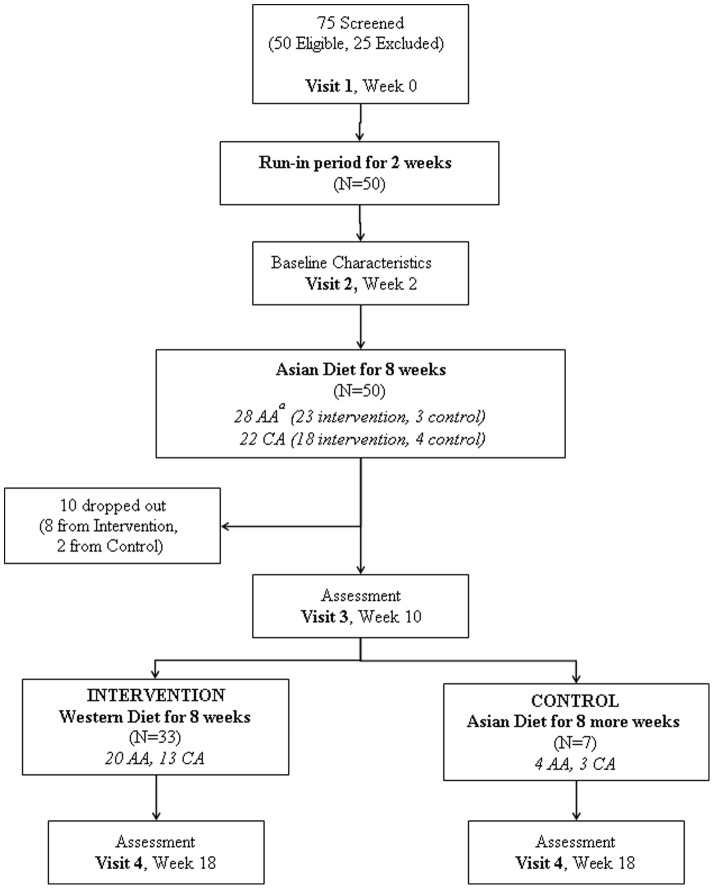
Flow of participants throughout the study.
aAA, Asian Americans; CA, Caucasian Americans.